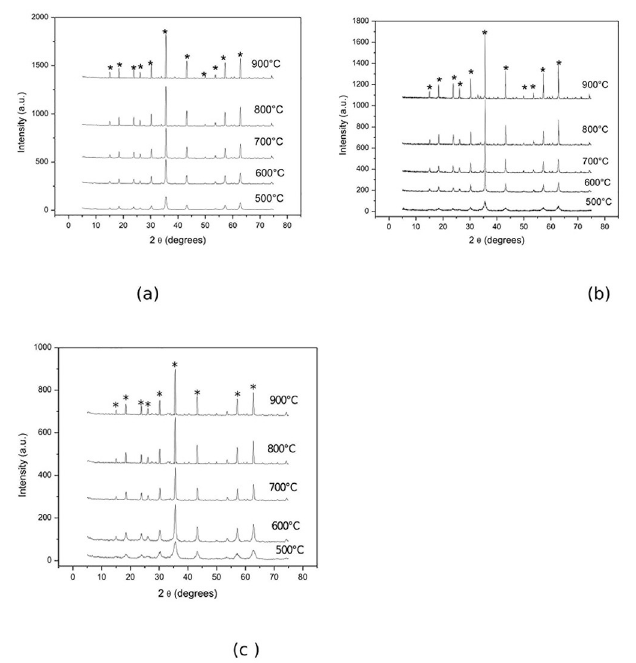
ZnTi O spinel doped with: (a) 0.01% mol % of Pr 3+ , (b) 0.05 mol% of Pr 3+ , (c) 0.1mol % in Pr 3+ 2 3 8